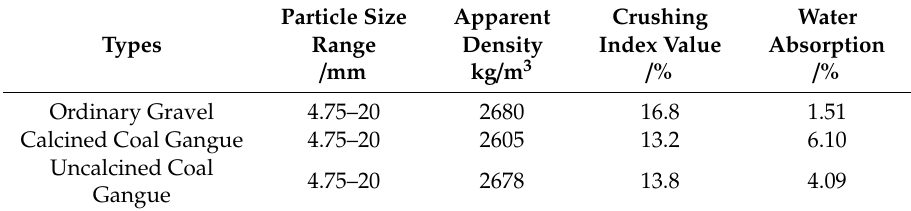
Table 2. Physical characteristics of coarse aggregates.